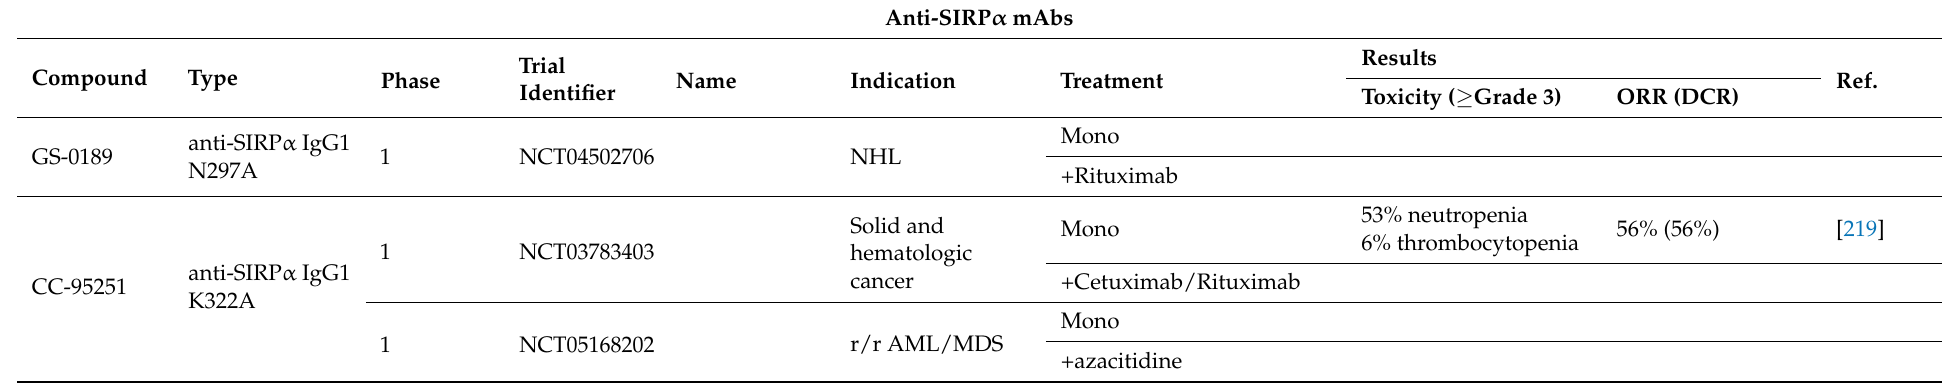
Table 4. SIRP α -targeting antibodies investigated in clinical trials. Currently, 3 anti-SIRP α mAbs are investigated in 7 clinical trials, as mono- or combination therapy for various indications. Table updated until 7 April